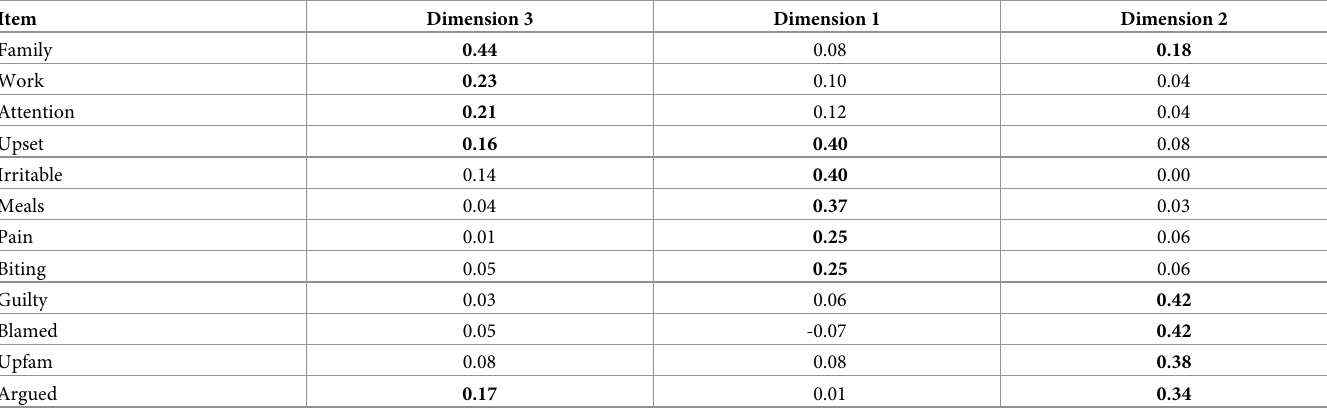
Table 2. Network loadings of the child perception